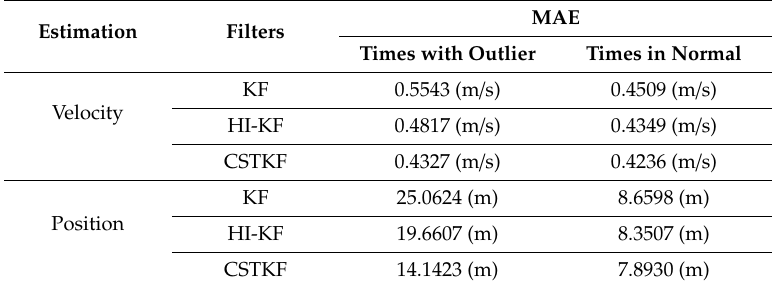
Table 2. Mean absolute error (MAE) of estimation under the condition of measurements with